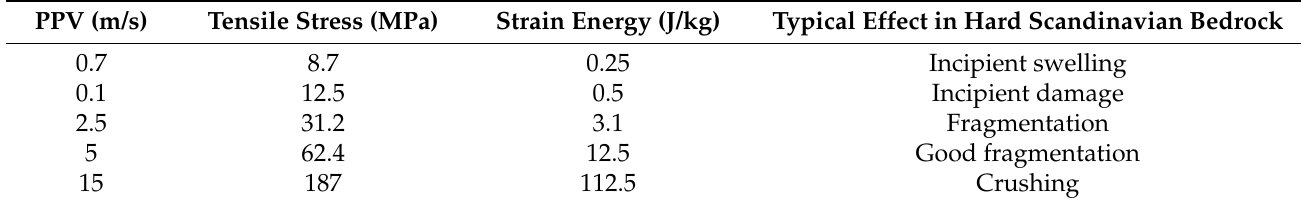
Table 4. Damage type based on induced PPV in a Scandinavian